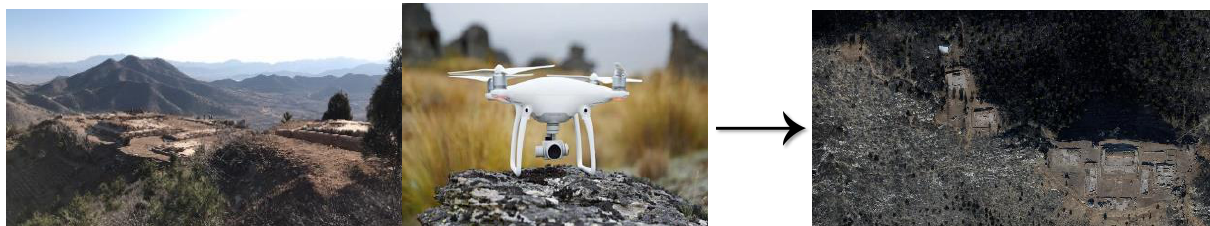
Figure 1. Unmanned Aerial Vehicle Used in Archaeology of